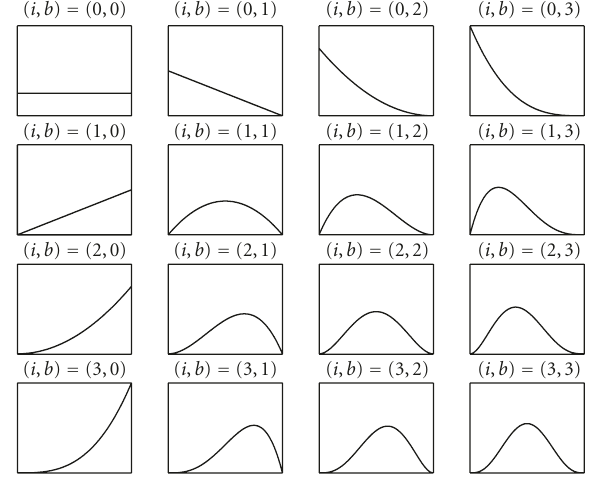
Figure 5: The distribution of p idle as a function of statistics i and b . As more information is gathered, the variance of the distribution